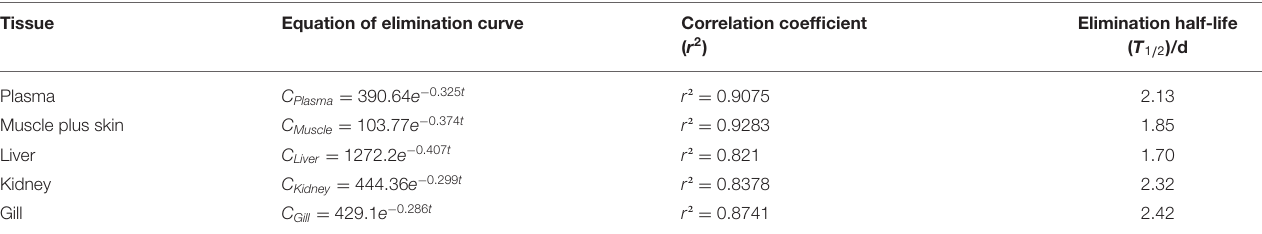
TABLE 4B | The equation of elimination curve, correlation coefficient ( r 2 ) and elimination half-life ( T 1 / 2 ) of Nile tilapia after daily oral administration of a single dose of 20 mg/kg for 5 days at 25 ◦ C.